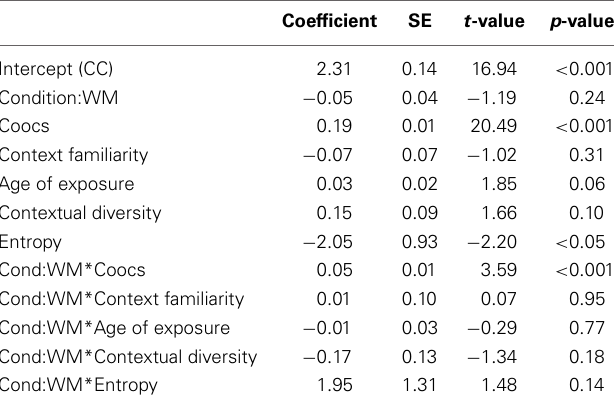
Table 1 | Regression coefficients predicting